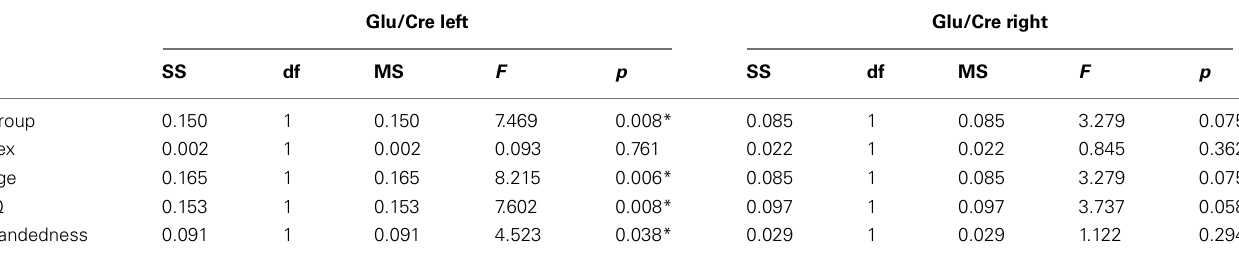
TableA2 | Main effects of general linear model including glutamate/creatine ratios at left side and right side, respectively, as dependent variables, group (ADHD, control) as categorical predictor, and sex (man, woman), handedness (left, right), age, and IQ as